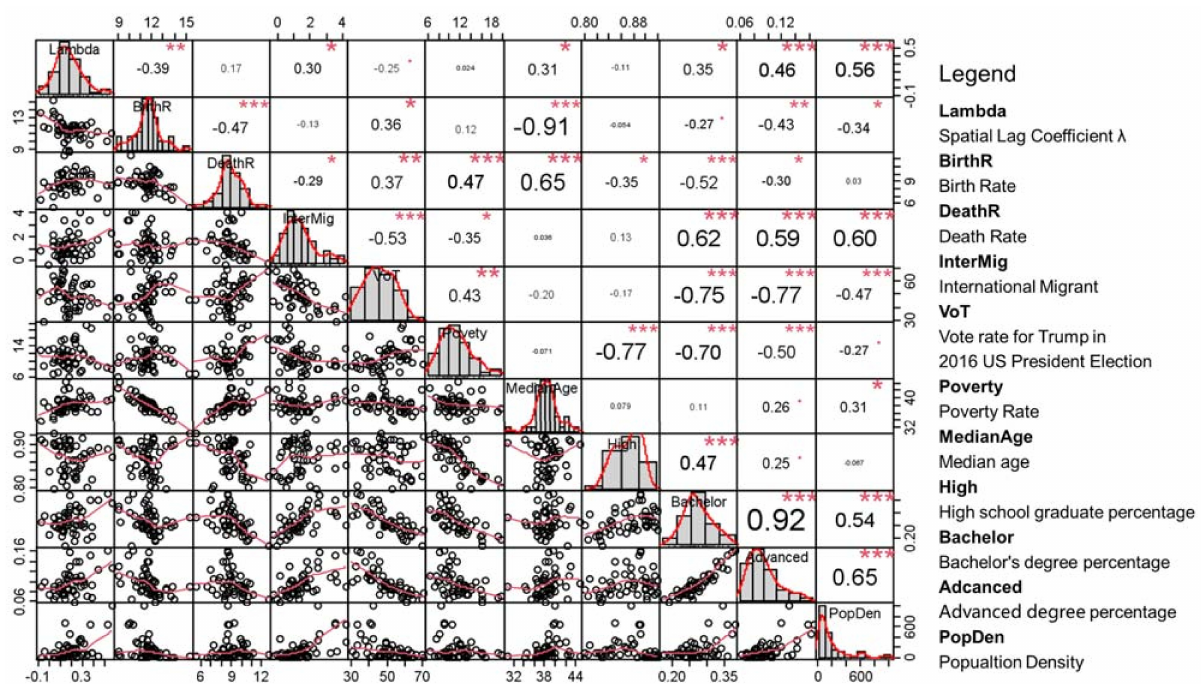
Figure 7. The correlation tests between λ and socioeconomic variables. The left part under the diagonal line in Figure 7 shows the scatter point plots, and the numbers are the correlation coefficients. The diagrams along the diagonal line are the histograms. Notes: ***, **, *, and · mean that correlation is significant at the 0.001, 0.01, 0.05, and 0.1 levels, correspondingly.